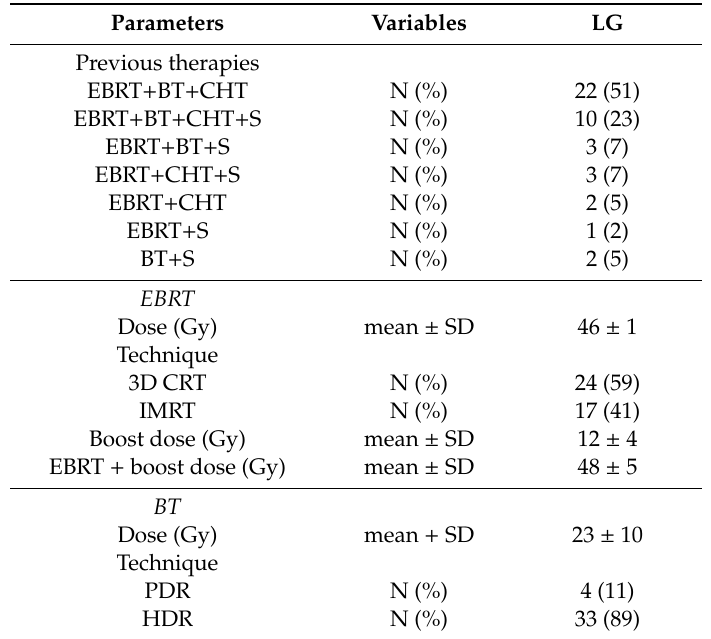
Table 2. Characteristics and doses of the treatments received by the study